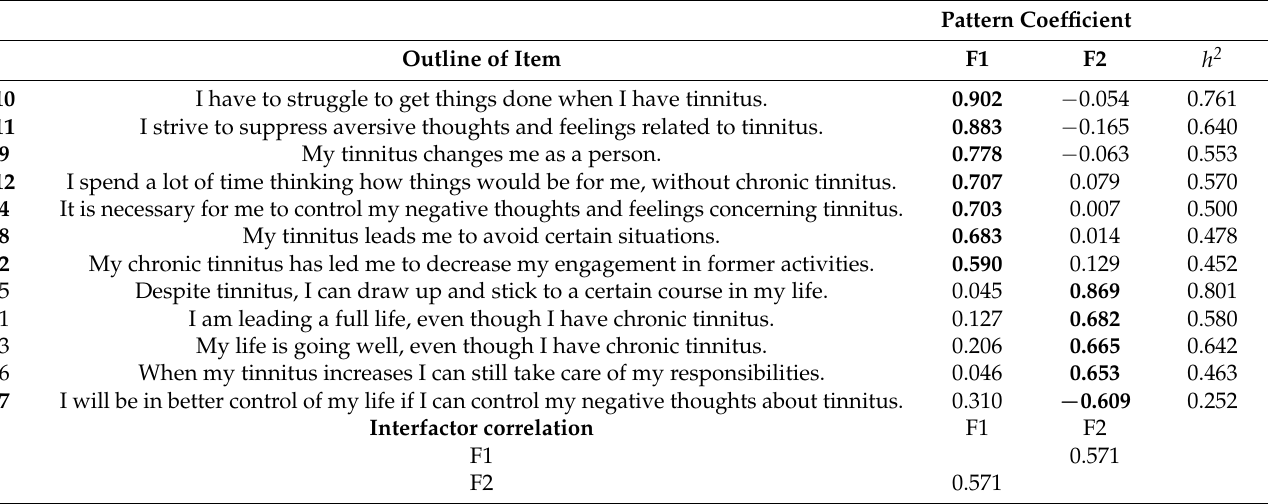
Figure 1. Scree plot of the TAQ items. Table 3. Coefficients of factor pattern and matrix, interfactor correlation, and commonality in the exploratory factor